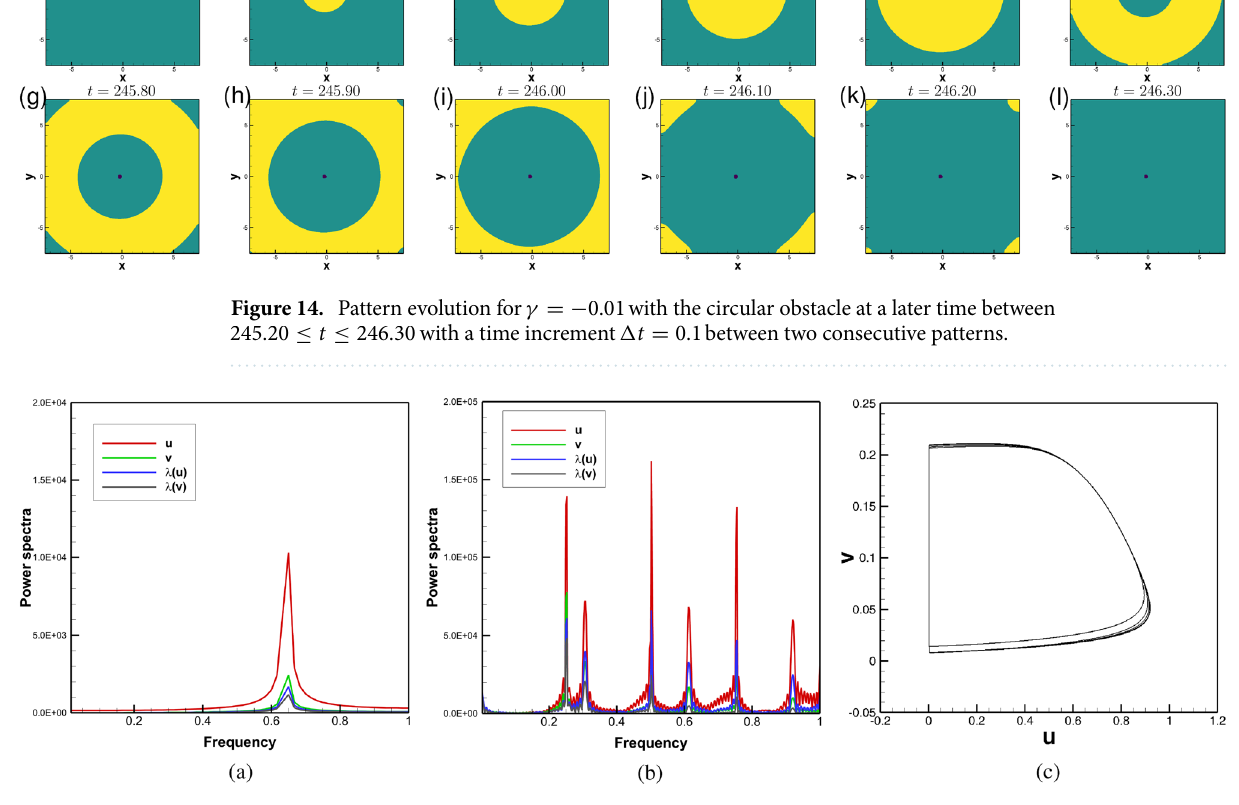
Figure 15. Power spectra of the local variables u , v and order parameters (cid:31) ( u ) , (cid:31) ( v ) for the spiral wave in exciting media with circular obstacle for: ( a ) γ = 0 in the time range 1400 ≤ t ≤ 1500 , ( b ) γ = − 0.01 in the time range 800 ≤ t ≤ 1200 and ( c ) phase portrait of the local variables u , v corresponding to ( b